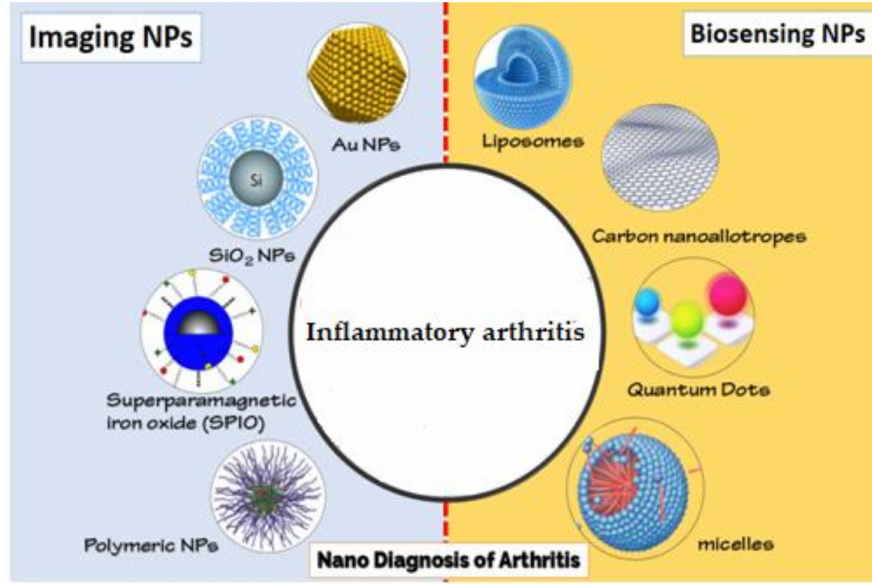
Figure 1. Different nanoparticles (NPs) for imaging and biosensing of inflammatory